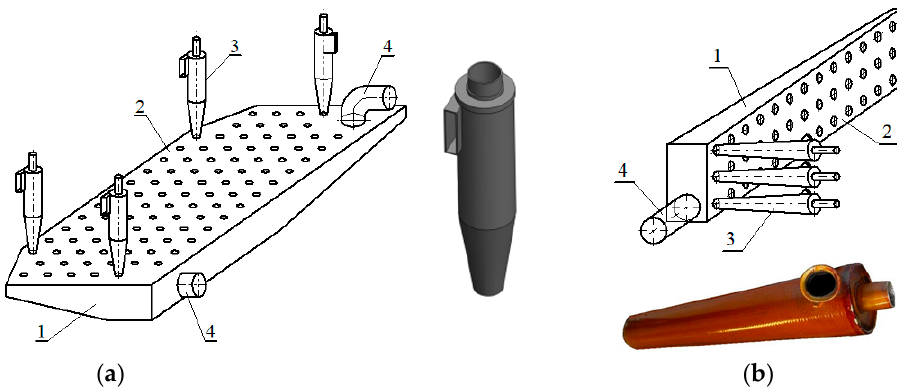
Figure 20. The construction of the dust collectors: ( a ) M72 multicyclone, ( b ) MB multicyclone, 1—dust collector chamber, 2—cyclone mounting plate, 3—cyclone, 4—suction stub-pipes.